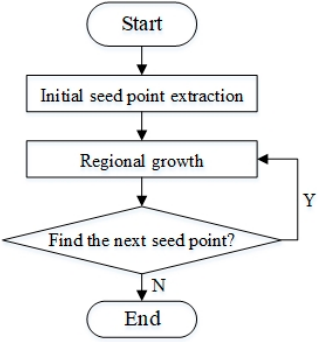
Figure 6. Workflow of the maize stalk segmentation.